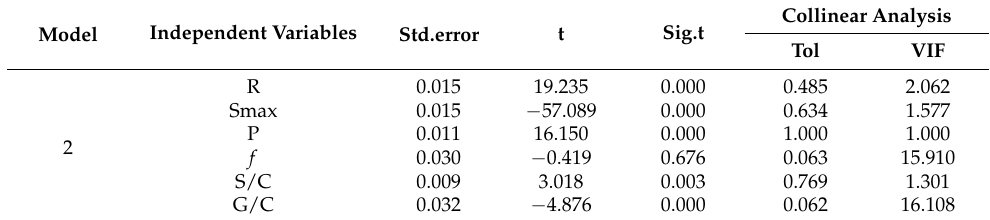
Table 7. Regression coefficient analysis of Model 1.